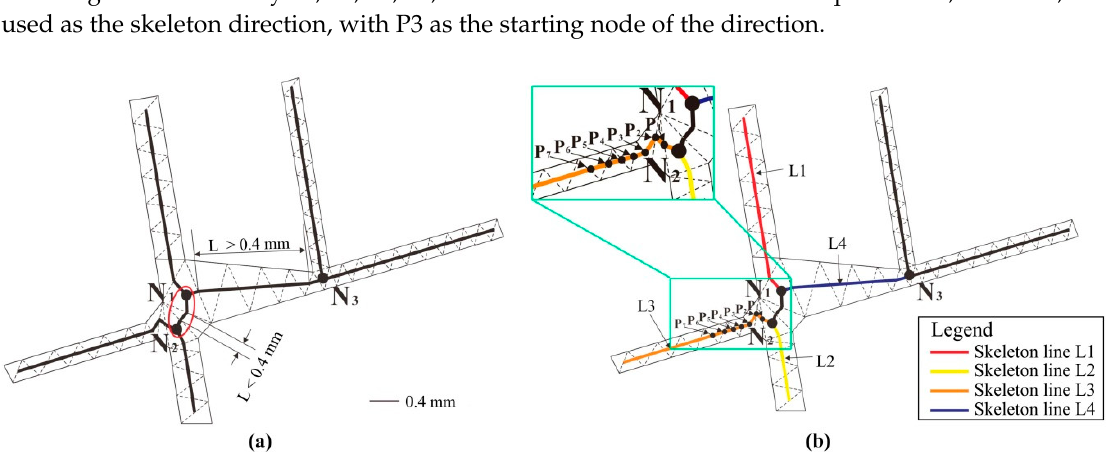
Figure 9. Two key steps in the jitter adjustment algorithm for the branch aggregation region: ( a ) defining the aggregation region and ( b ) computing skeleton line direction.